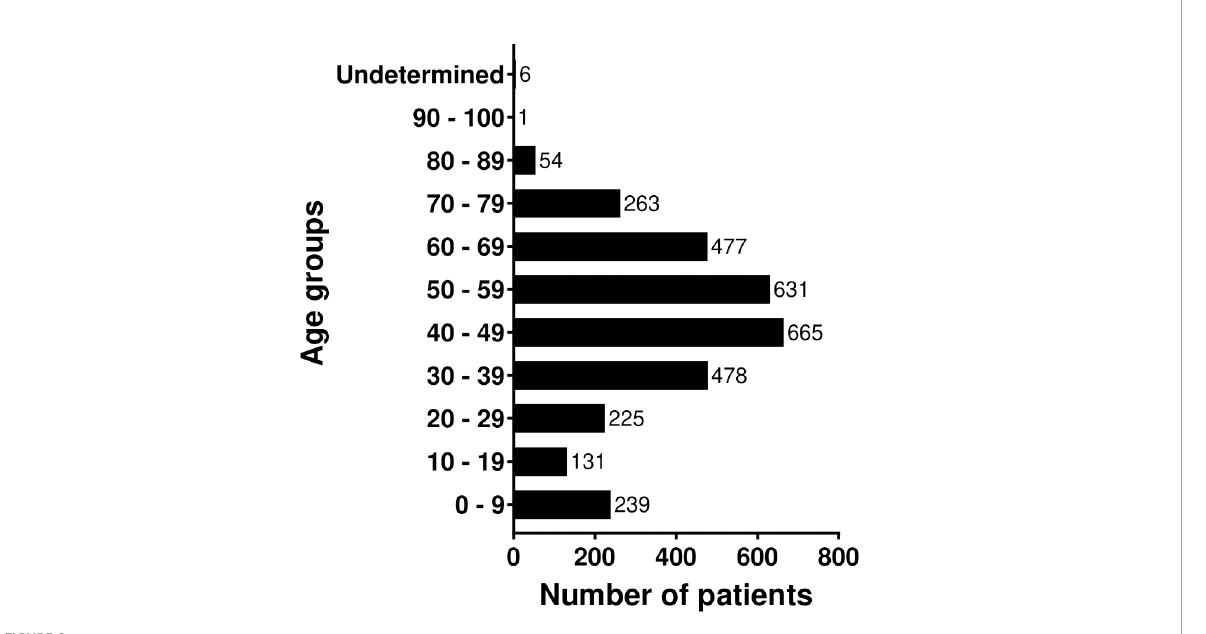
FIGURE 2 Libyan patients with cancer age